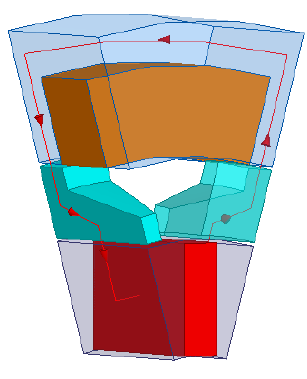
Figure 3. Flux path in one pole of the